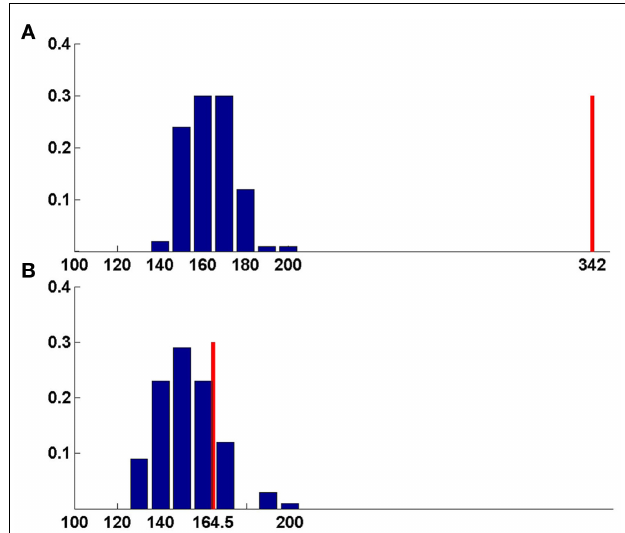
FIGURE 4 | Bootstrapping method for function prediction. Blue- random scores, red-best match score. (A) Chain v of 3KIS, (B) chain w of 3KIS. For chain v, the best score is significantly larger than random average score giving correct prediction, whereas for chain w, best match score lies within the range of random scores, leading to false prediction ( Table 4